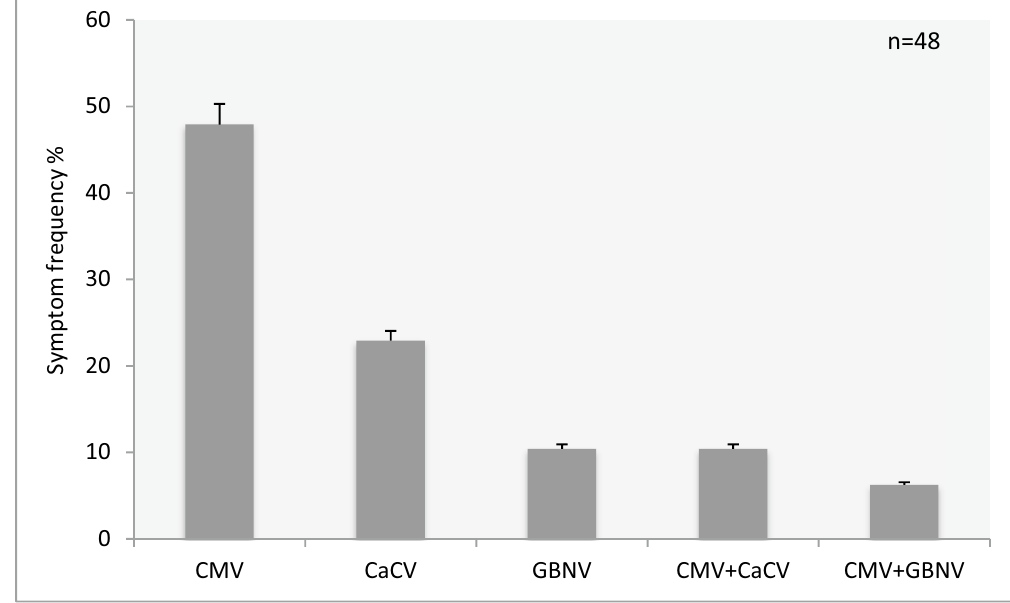
Figure 2. Per cent disease incidences of CMV, CaCV and GBNV infections of chilli in Tamil Nadu. The bar graph indicates that infection ratios of CMV (47.91%), GBNV (22.91%), CaCV (10.41%), CMV with CaCV (10.41%) and CMV with GBNV (6.25%) in chilli.